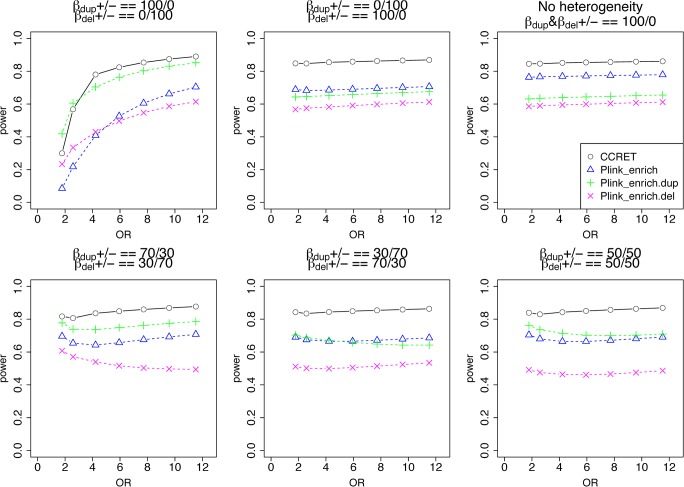
Power comparison between CCRET and PLINK 2-sided tests for simulation II-A: between-locus heterogeneity of the GI simulation, under 6 heterogeneity models as detailed in section “Simulation Design”.Black O line: CCRET; Blue Δ: PLINK 2-sided test analyzing deletions and duplications combined; Green +: PLINK 2-sided test analyzing only duplications; Magenta x: PLINK 2-sided test analyzing only deletions.